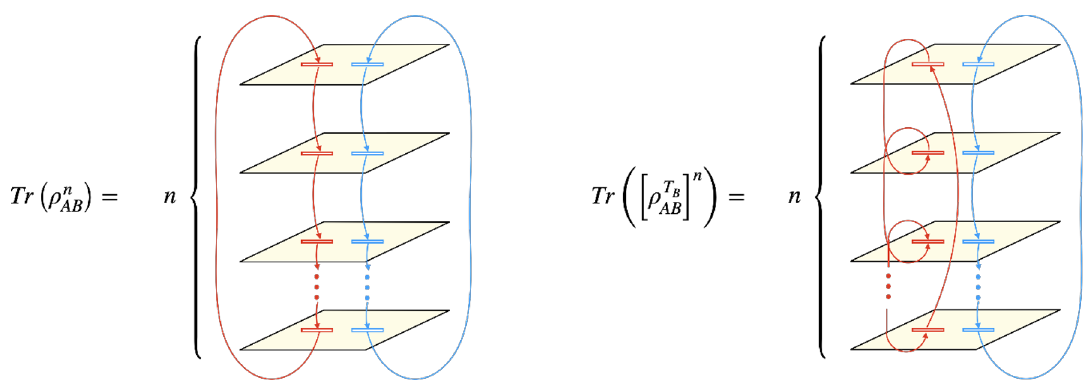
Figure 2 . Left: the path integral representation for the moments of the reduced density matrix ρ AB . The n sheets are glued cyclically in the same order for both region A (red) and region B (blue). Right: the path integral representation for the moments of the partially transposed reduced density matrix. Note that region A is now glued anti-cyclically. This is the action of the partial